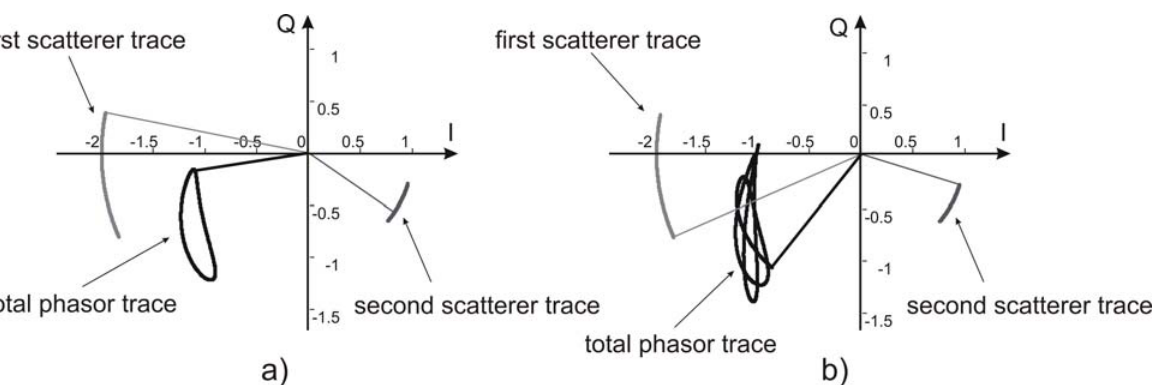
Figure 2. Phasor traces of the simulated signal due to two scatterers at distance 1.02 m and 0.99 m, with a sinusoidal motion with 6mm and 4 mm peak-to-peak amplitude respectively. (a) oscillation at 0.25 Hz movement have a phase shift of  /3. (b) oscillation frequencies are 0.25 Hz e 0.30 Hz